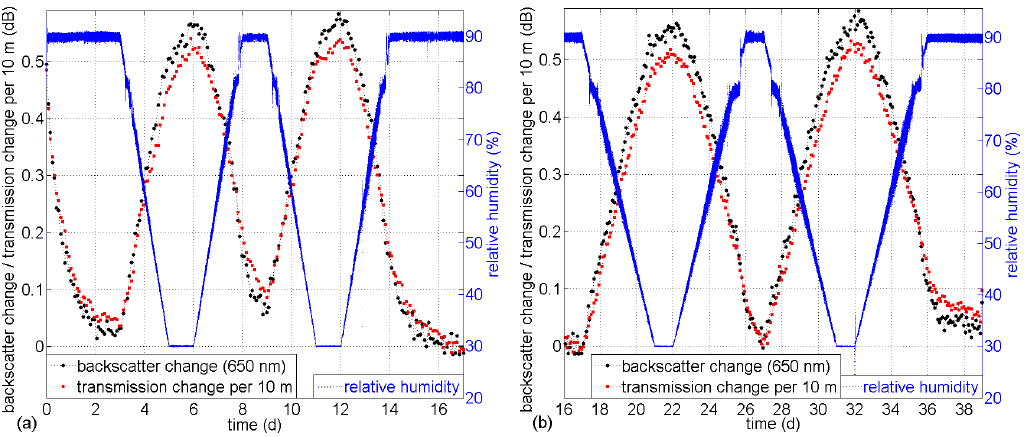
Figure 6. Backscatter change and transmission change during gradual RH changes at 650 nm wavelength ( a ) for slope durations of 2 days and ( b ), continued, for slope durations of 4 days.